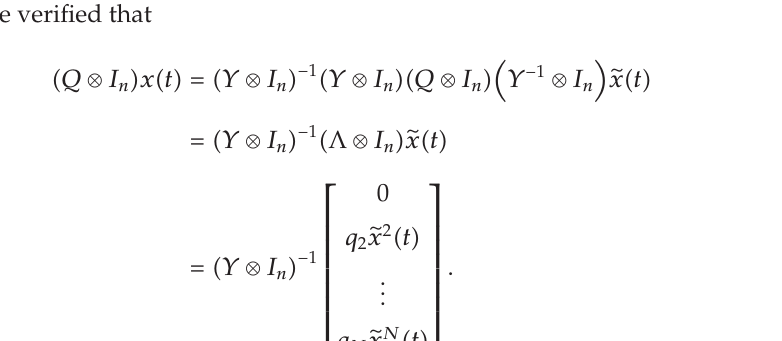
(cid:6) t (cid:7) , i (cid:9) 1 , 2 , 3 , 1